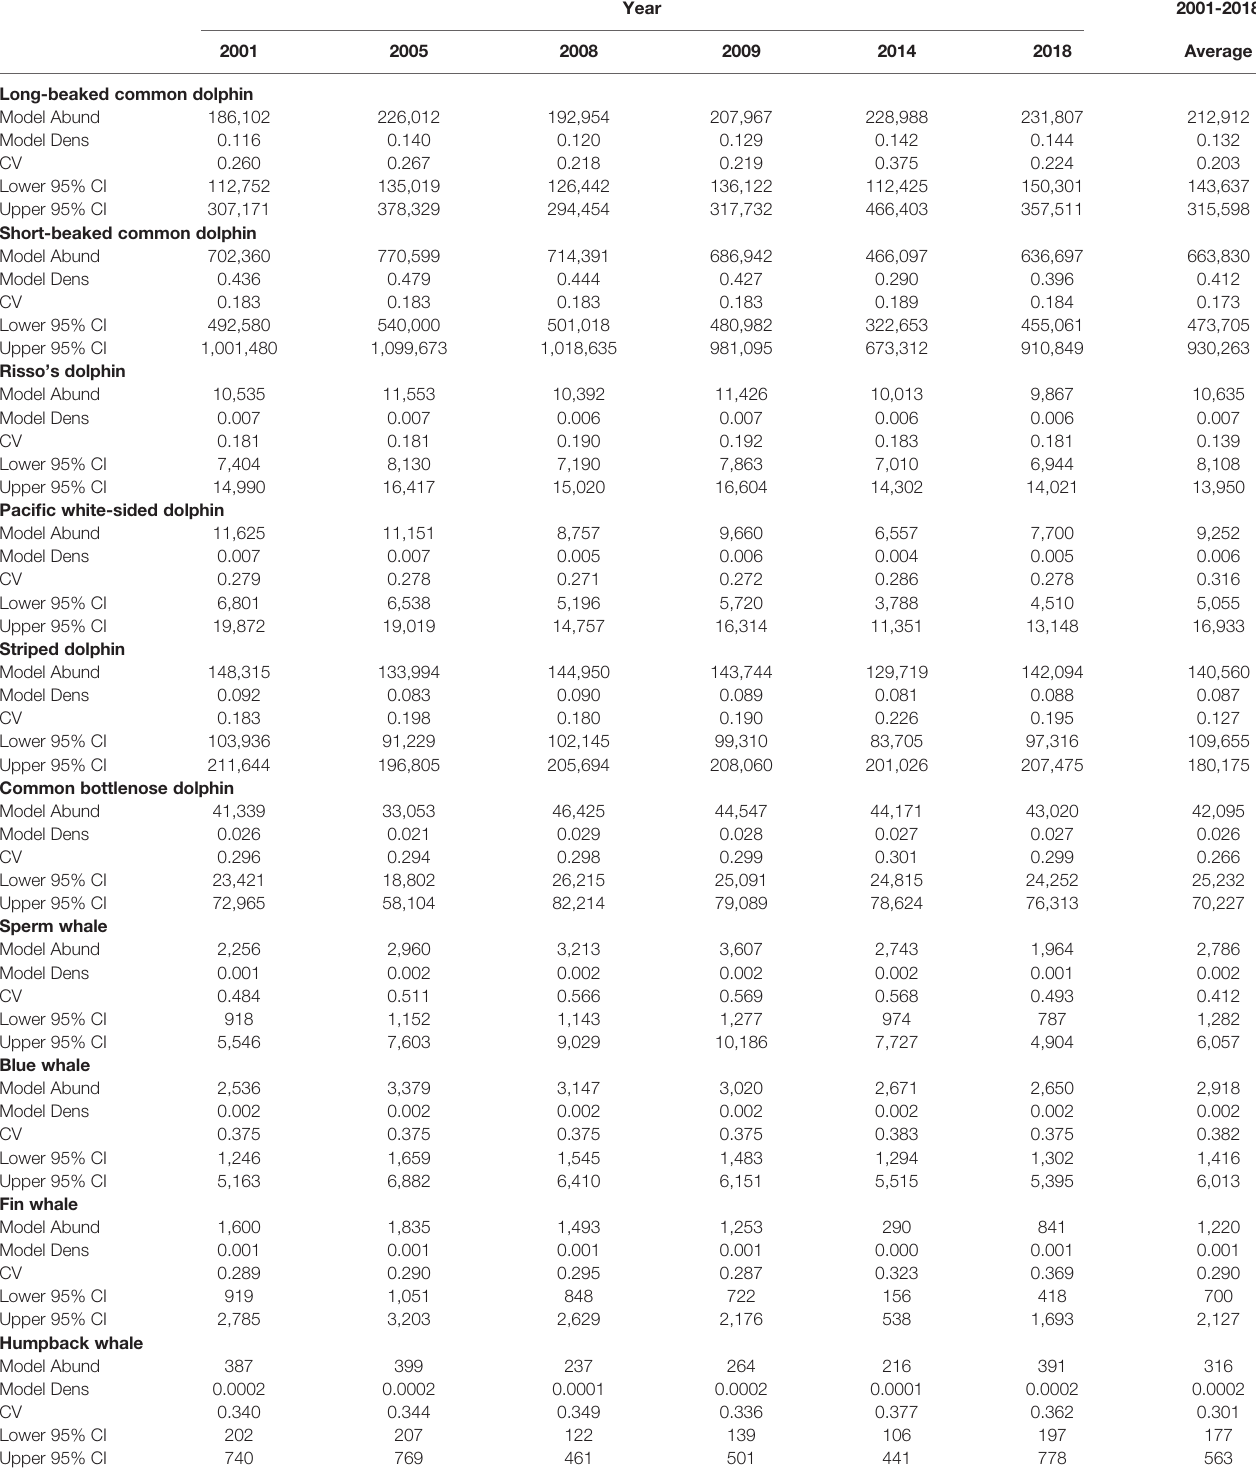
TABLE 5 | Annual and multi-year (2001 – 2018) model-predicted mean estimates of abundance (Abund), density (Dens; animals km-2), and corresponding coef fi cient of variation (CV) within the Southern California Current study